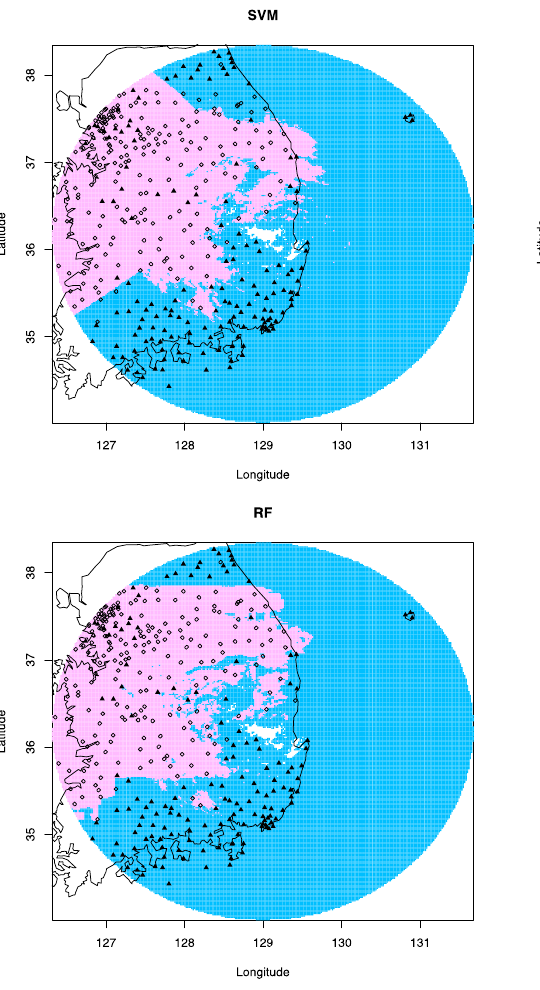
Figure 6. Estimated precipitation areas, dry (blue) and wet (red), on 31 July 2017. Circle and triangle indicate wet and dry observed in the stations, respectively .